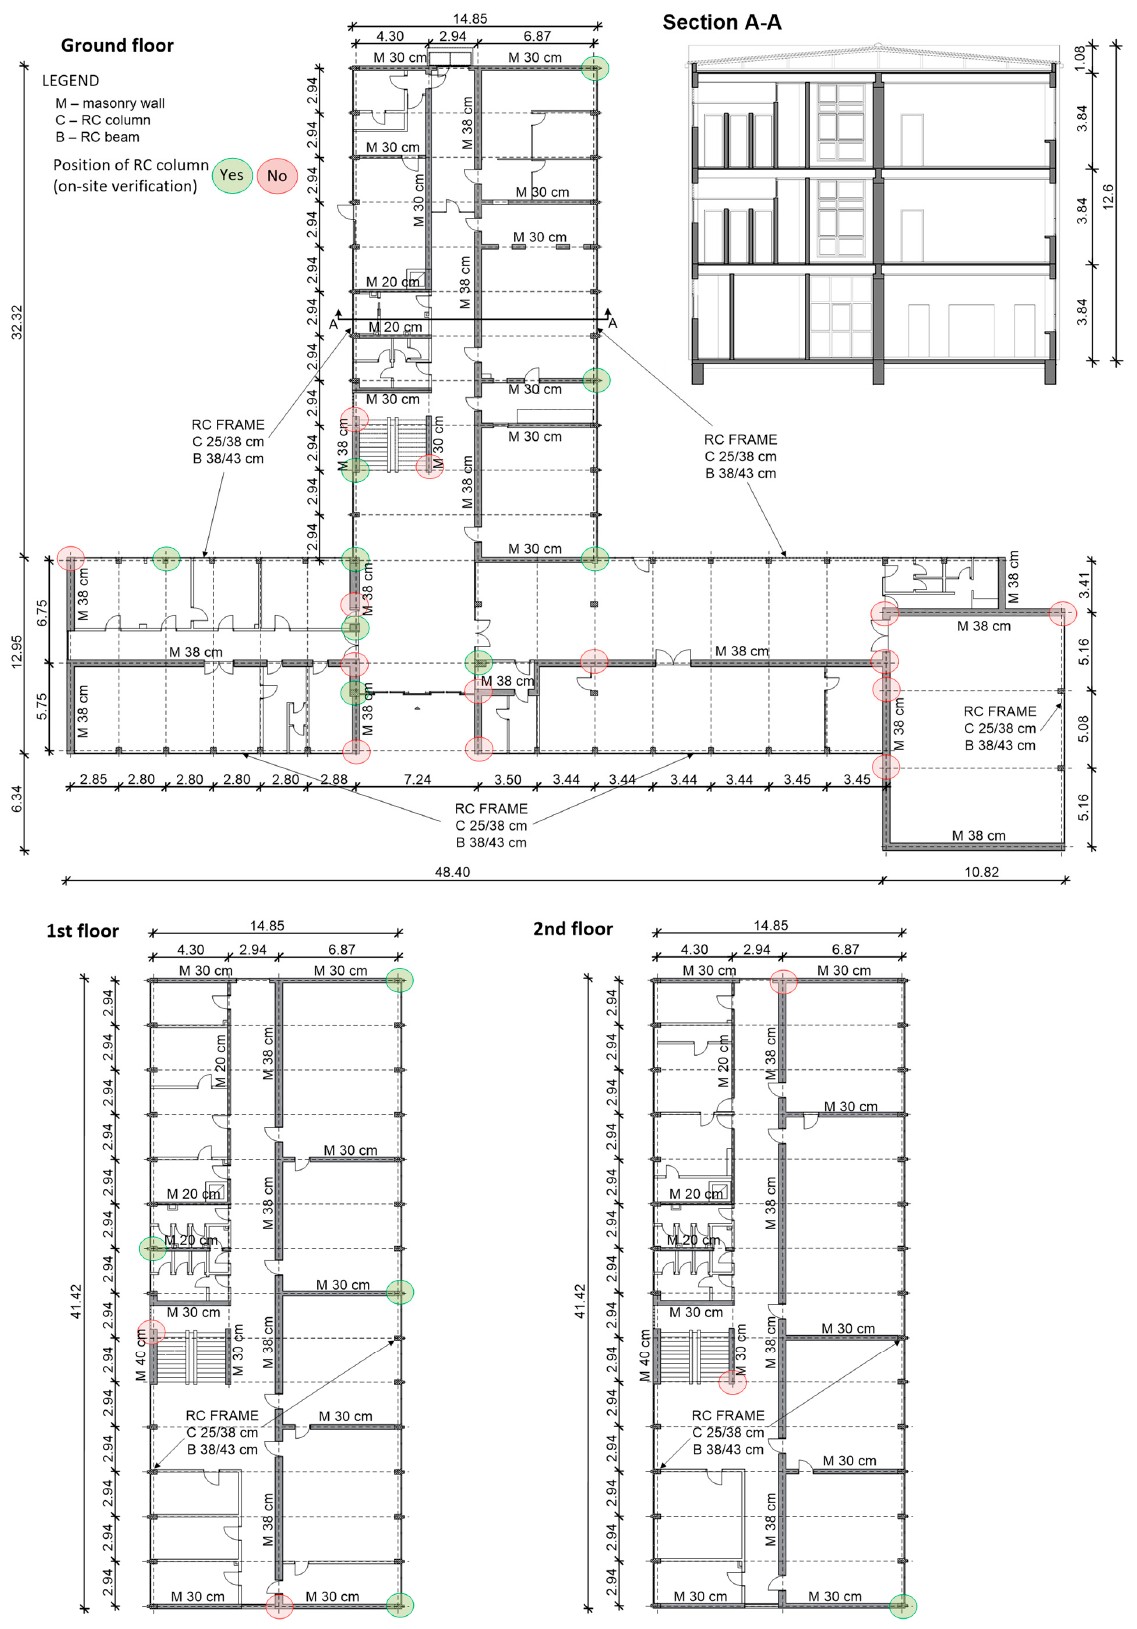
Figure 5. Layout of the building stories and markings of gravity and lateral load resisting system dimensions.